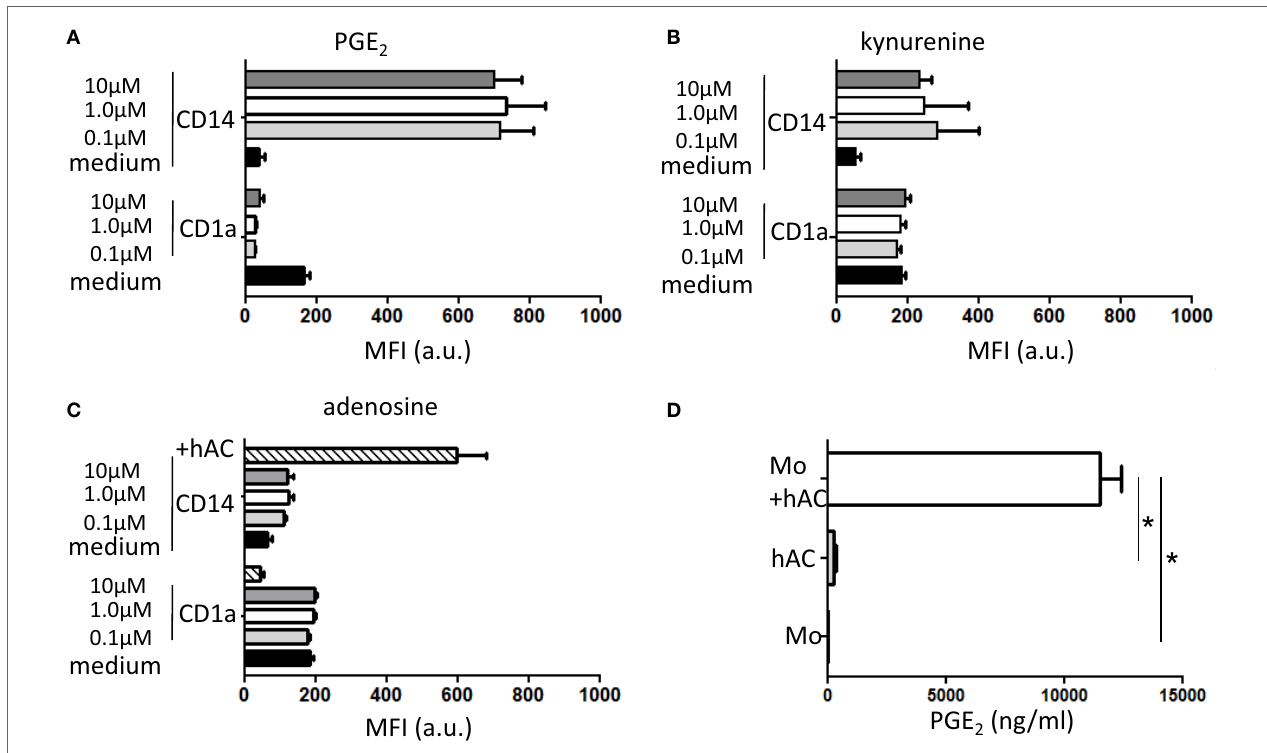
FigUre 6 | effect of Pge 2 , kynurenine, and adenosine on differentiation of Mo to iDc and presence of Pge 2 in conditioned media of hac–Mo co-cultures . To determine the effect on the expression of exogeneous PGE 2 (a) or kynurenine (B) or adenosine (c) , Mo from PBMC were induced to differentiate to iDC with GM-CSF and IL-4 and incubated starting at the onset of culture with different doses (as indicated) of these three drugs. The expression of CD1a and CD14 antigens were assessed with direct immunofluorescence using CD1a–FITC and CD14PE–Cy7 mAbs on day 6 of culture. Medium indicates the expression of CD1a and CD14 in cultures without the addition of any drug and it represents the typical differentiation of Mo to iDC. In (c) , lined bar represents the expression of CD1a and CD14 in co-cultures with hAC showing the impairment in Mo differentiation to iDC. Results are shown as mean of fluorescence intensity of each marker and are the mean ± SD of three independent experiments for each drug. (D) The conditioned media (CM) from Mo co-cultured with hAC with GM-CSF and IL-4 was harvested on day 4 of culture and analyzed for the presence of PGE 2 using a specific ELISA. The amount of PGE 2 in CM from hAC or Mo is shown for comparison. Results are the mean ± SD of determination of three independent experiments. * p <